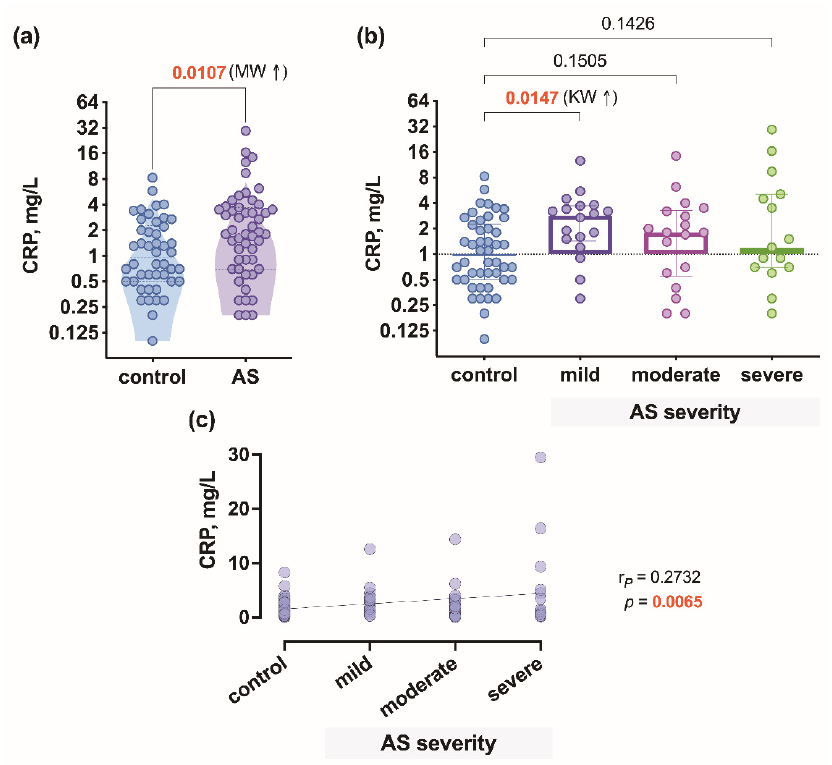
Figure 1. Plasma CRP level: ( a ) comparison of CRP concentration in control subjects and aortic valve stenosis (AS) patients; ( b ) comparison of CRP concentration in control subjects and AS patients with 3 different severity degrees; ( c ) correlation of CRP regarding AS severity degrees. r P —Pearson’s cor- relation coefficient; MW—Mann–Whitney test, KW—Kruskal–Wallis test with a post hoc procedure. Table 1. Basic data of individuals in the control group and patients in the AS groups.